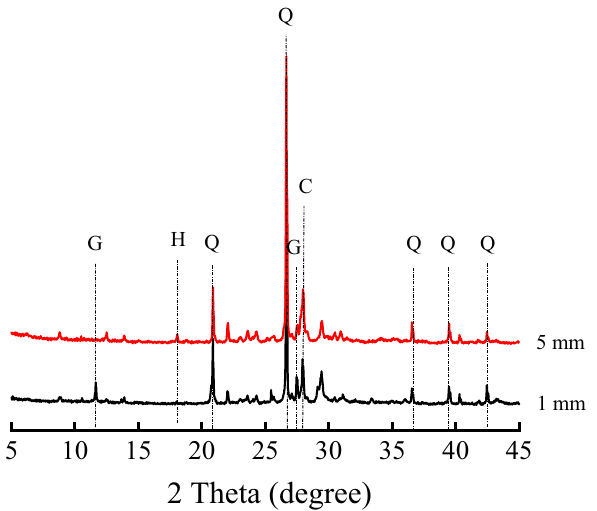
Figure 10. XRD patterns of concrete under the action of CO 2 and SO 2 . Q Quartz (SiO 2 ), G Gypsum (CaSO 4